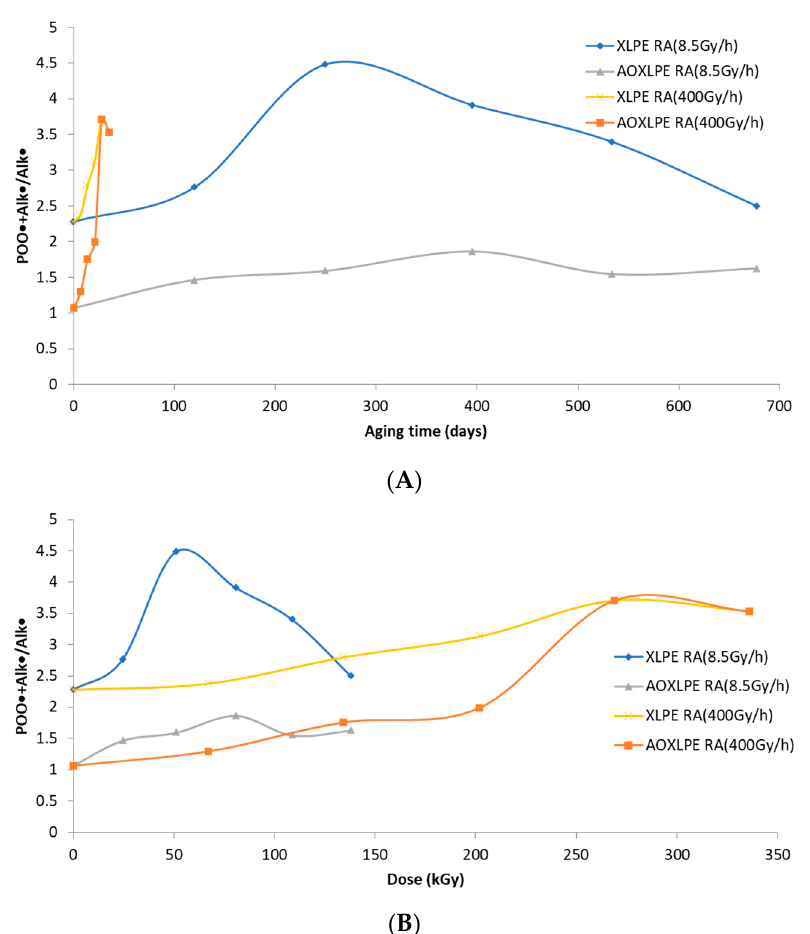
Figure 7. The relative proportion (POO • + Alk • )/Alk • signals (as measured by the ratio of signal intensities at g = 2.0318 and g = 1.9692, respectively) changes ( A , in the function of aging time, B , in the function of dose) with the degree of aging of the material, for the samples of XLPE and